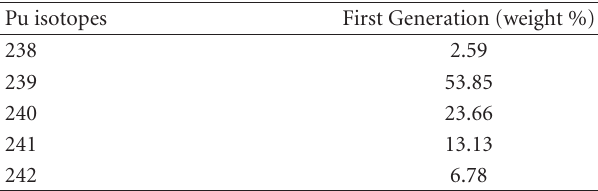
Table 3: Composition of 1st generation Pu [10, 11].